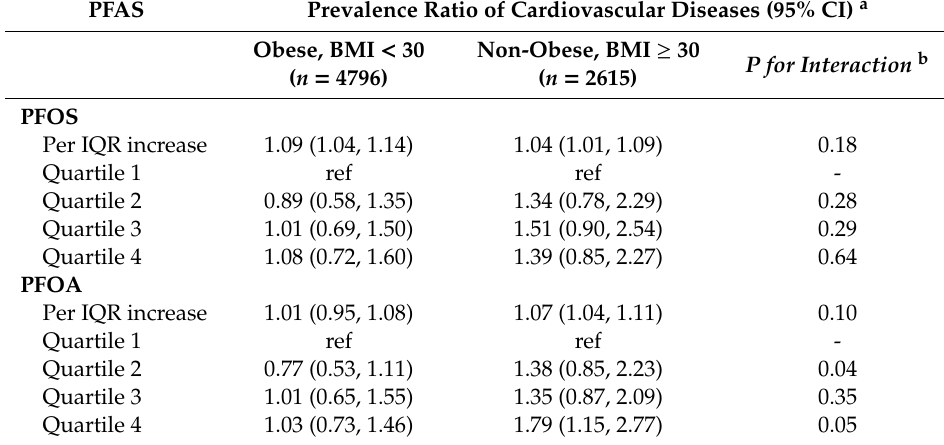
Table 4. Associations between serum PFAS levels (ng / mL) and cardiovascular diseases stratified obesity status indicated by body mass index